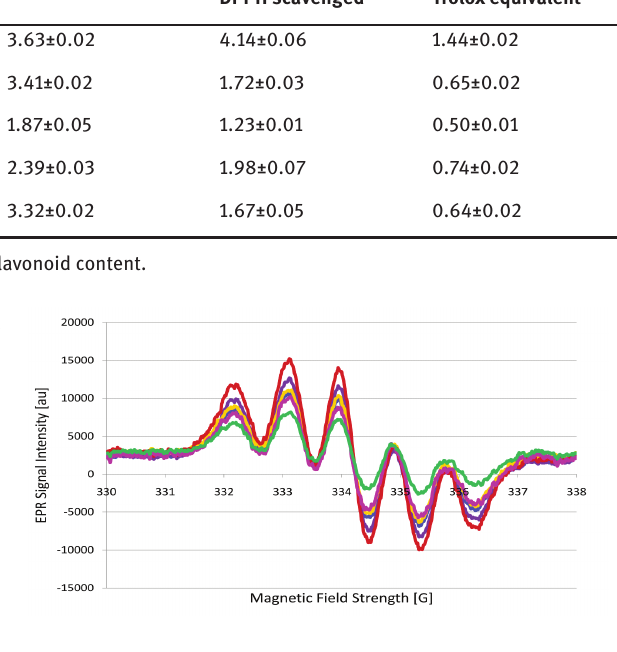
Figure 2: EPR spectra of DPPH solution (red graph) and of DPPH solution + E. brasiliensis extracts from various origins: green (Ebe),